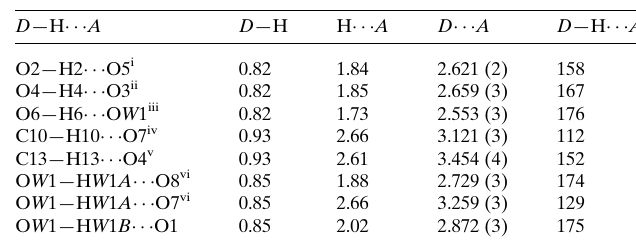
Table 1 Hydrogen-bond geometry (A˚ , (cid:5) ).